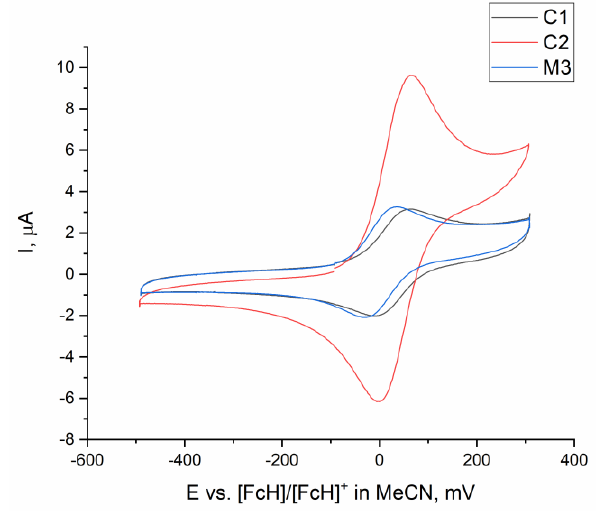
Figure 2. Cyclic voltammogram of M3 (1 mM), C1 (1 mM) and, C2 (3 mM) in MeCN at room temperature, with 0.10 M [N( n Bu) 4 ]PF 6 as supporting electrolyte, a glassy carbon electrode (surface area 0.001 cm 2 ), a Ag/AgNO 3 (0.01 mol∙l − 1 ) reference electrode, a Pt wire (99.9%) counter electrode, and a voltage sweep rate ν = 100 mV∙s −1 .